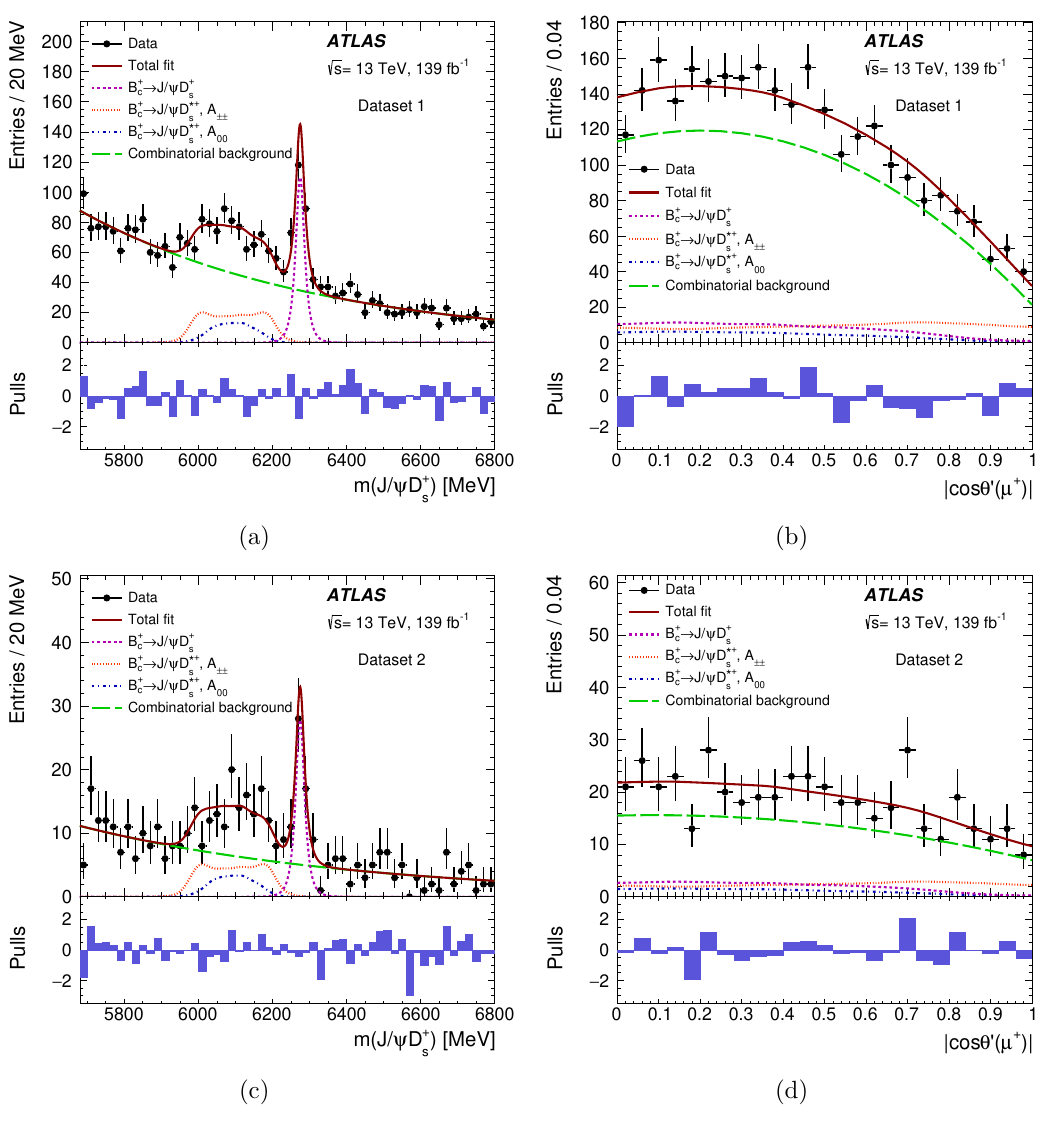
mass and ((b), (d)) | cos θ 0 ( µ + ) | for the selected Figure 2 . Distributions of ((a), (c)) the J/ψD + s B + → J/ψD ( ∗ )+ s candidates in ((a), (b)) Dataset 1 and ((c), (d)) Dataset 2. Data are shown as c points, and the overall result of the fit is given by the red solid curve. The purple dashed line shows the contribution of the B + signal, while the orange dotted and blue dashed-dotted lines → J/ψD + c s show the contributions of the A and A components of the B + signal, respectively. → J/ψD ∗ + ±± 00 c s The background contribution is shown with the green long-dashed line. The bottom panels show the pulls, defined as the difference between the data and the fit function divided by the uncertainty of the data